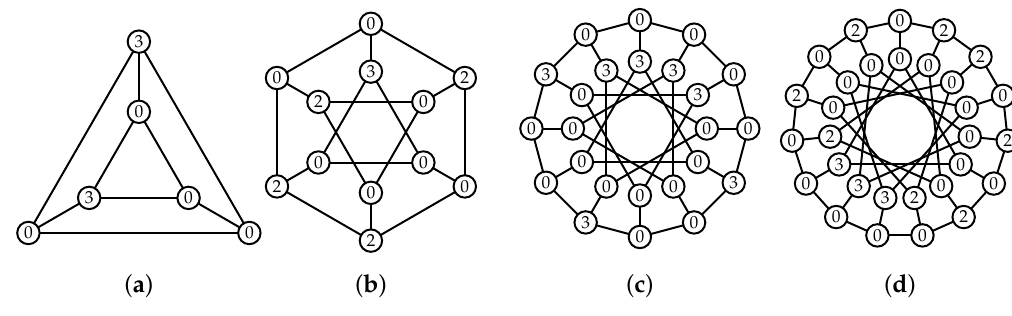
Figure 2. ( a ) A DRDF of P ( 3,1 ) ; ( b ) A DRDF of P ( 6,2 ) ; ( c ) A DRDF of P ( 12,4 ) ; ( d ) A DRDF of P ( 15,5 ) .